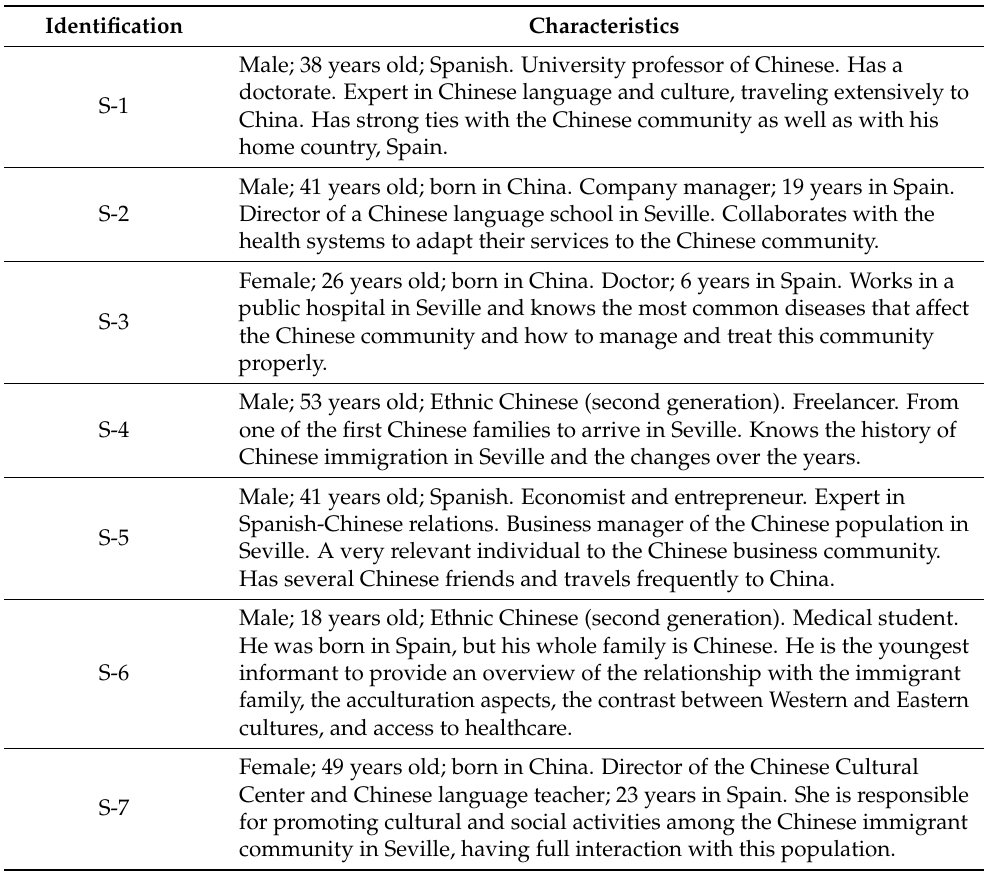
Table 1. Profile of